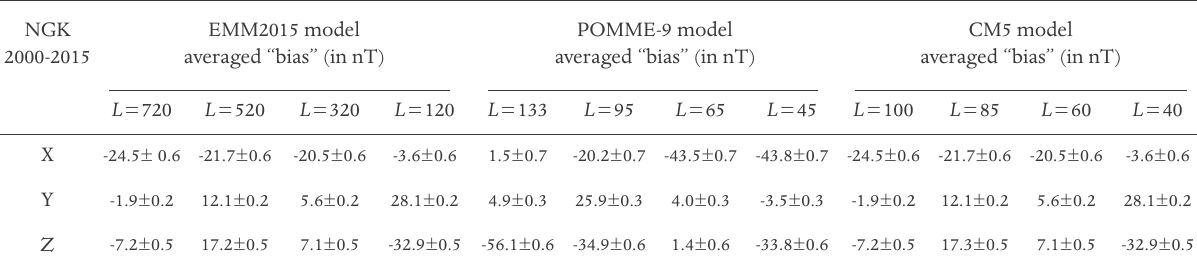
Table 1. Averaged “bias” of different models at NGK observatory (2000-2015